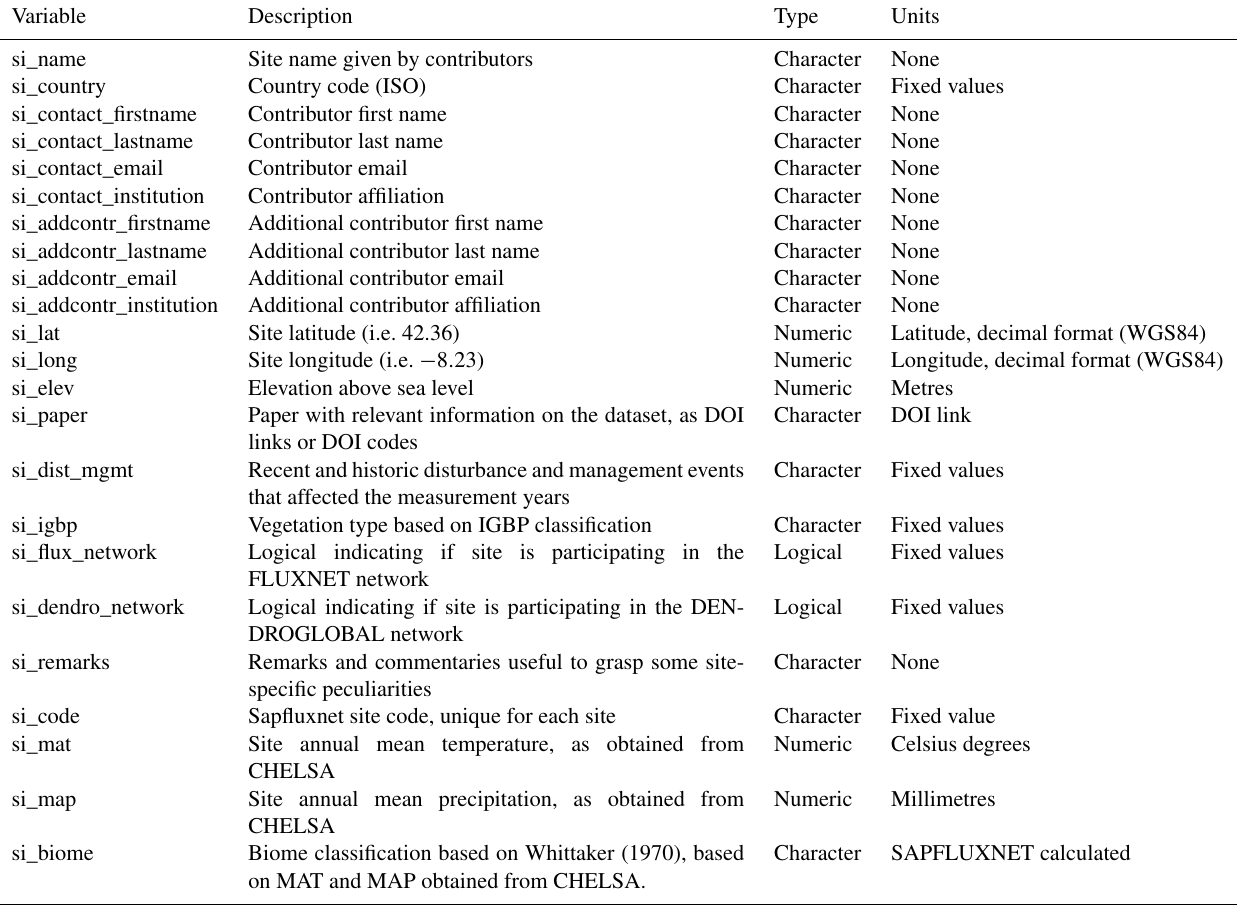
Table A2. Description of site metadata variables in SAPFLUXNET datasets.